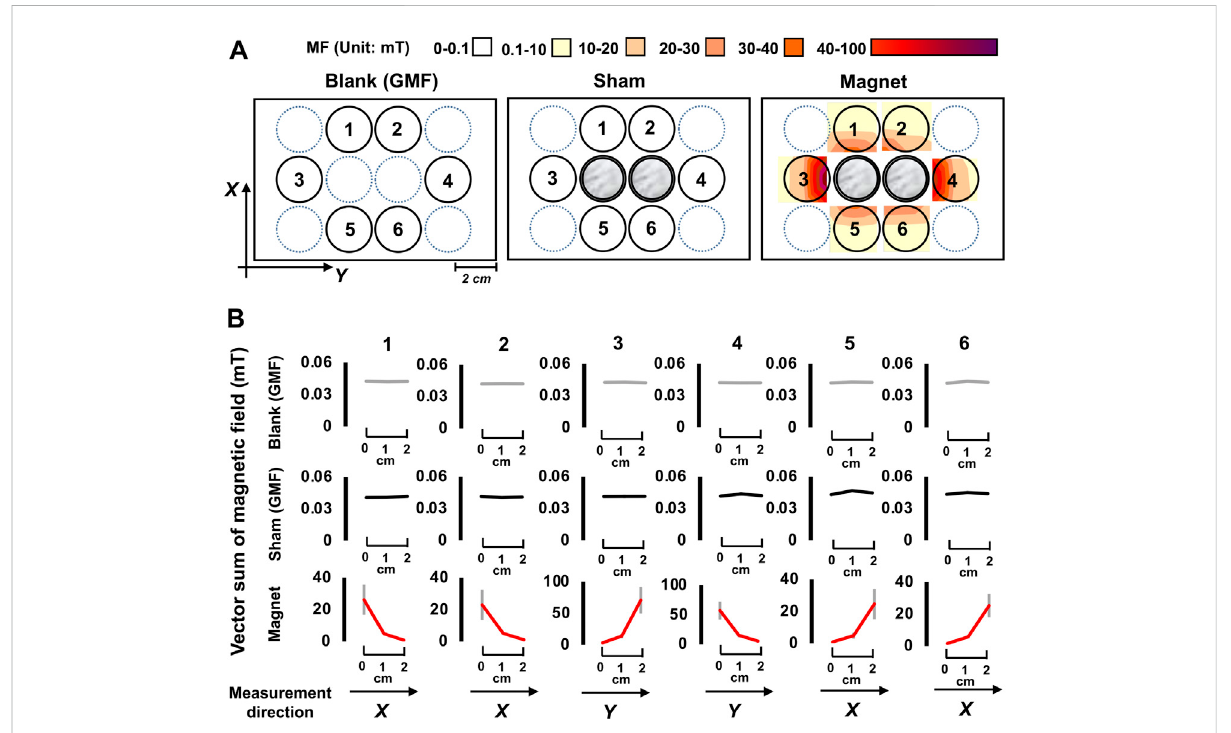
FIGURE 1 The experimental setup and magnetic fi eld conditions. (A) The distributions of the magnetic fi eld (vector sum) at the bottom plane of a 12-well plate for the blank, sham, and magnetic treatments are shown. Tadpoles were placed in wells with Arabic numerals 1 to 6. The central two wells (in gray)werethepositionsformagnetic(magnets)orsham(nickelcoins)treatments.Blackarrowsindicatedirectionofthemagnetic fi eld. X -axis,South to North; Y -axis, East to West, MF, magnetic fi eld. (B) The distribution of magnetic fi eld vector sum along the X- or Y -axis, data are shown as mean ± standard deviation (SD) of the vector sum in each test